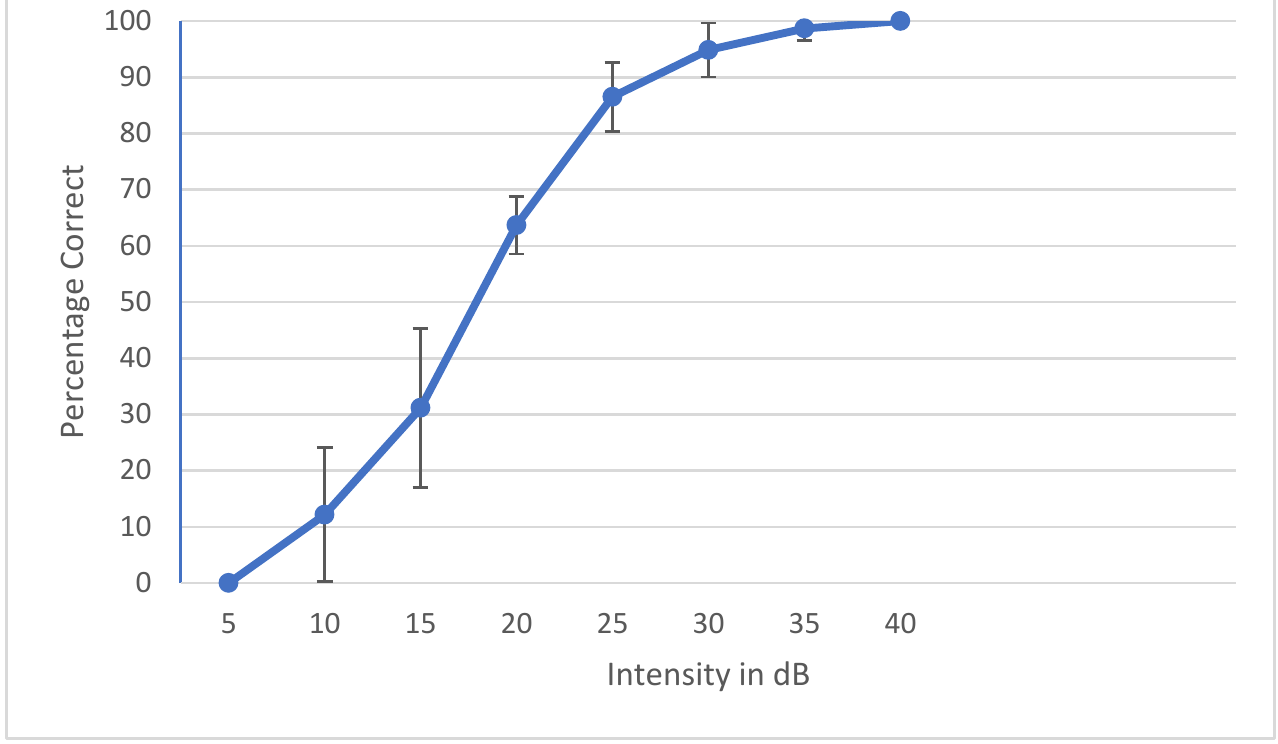
Figure 5. Average psychometric properties for the Maltese AAST words in adults in high frequency.